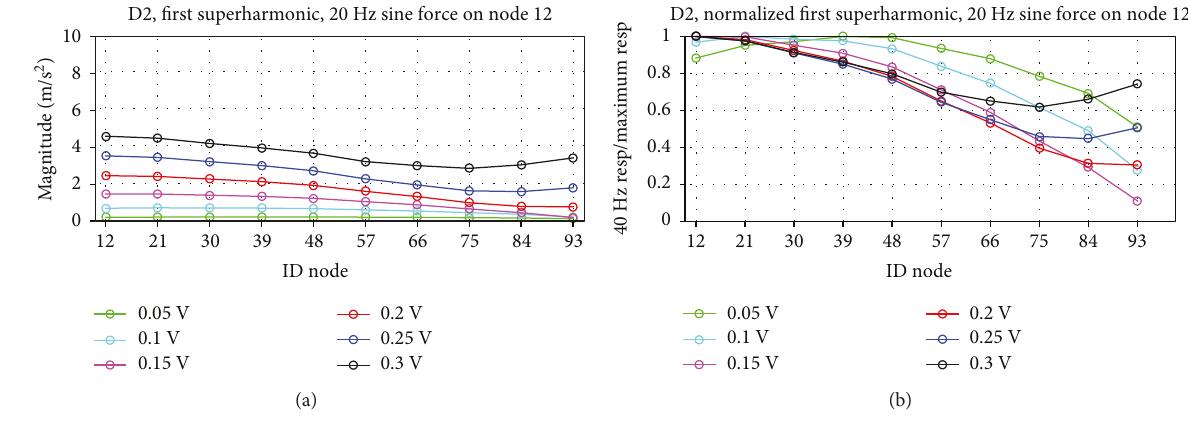
Figure 47: 40 Hz FFT magnitudes, 20Hz sine excitation force applied to node 12, D2